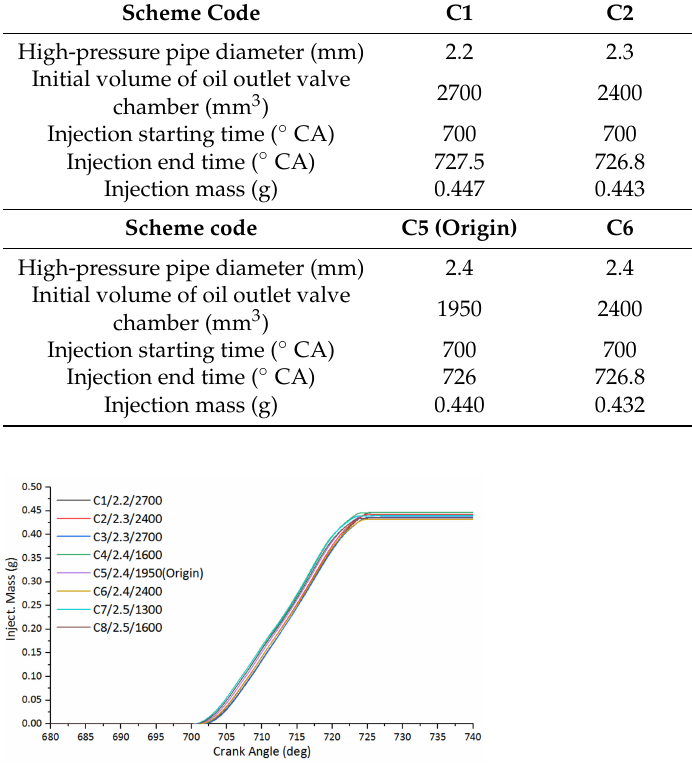
Figure 30. Volume optimization plan for injection